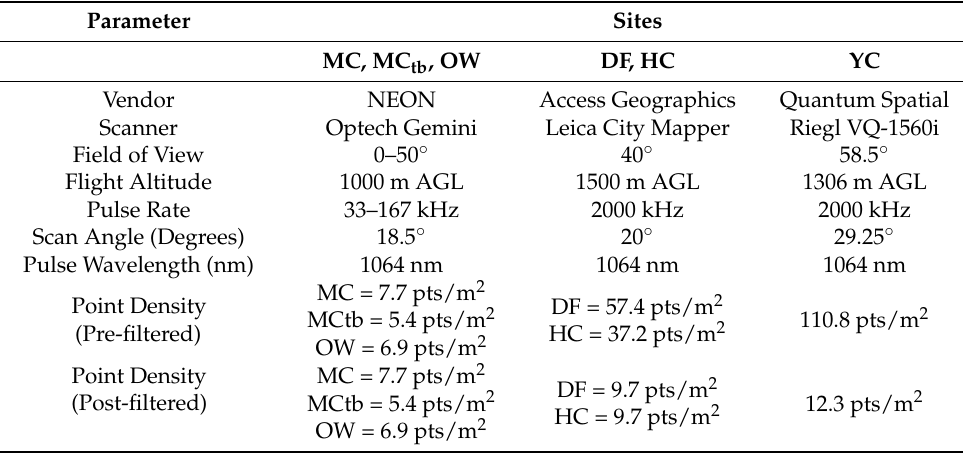
Table 2. Site specific lidar acquisition